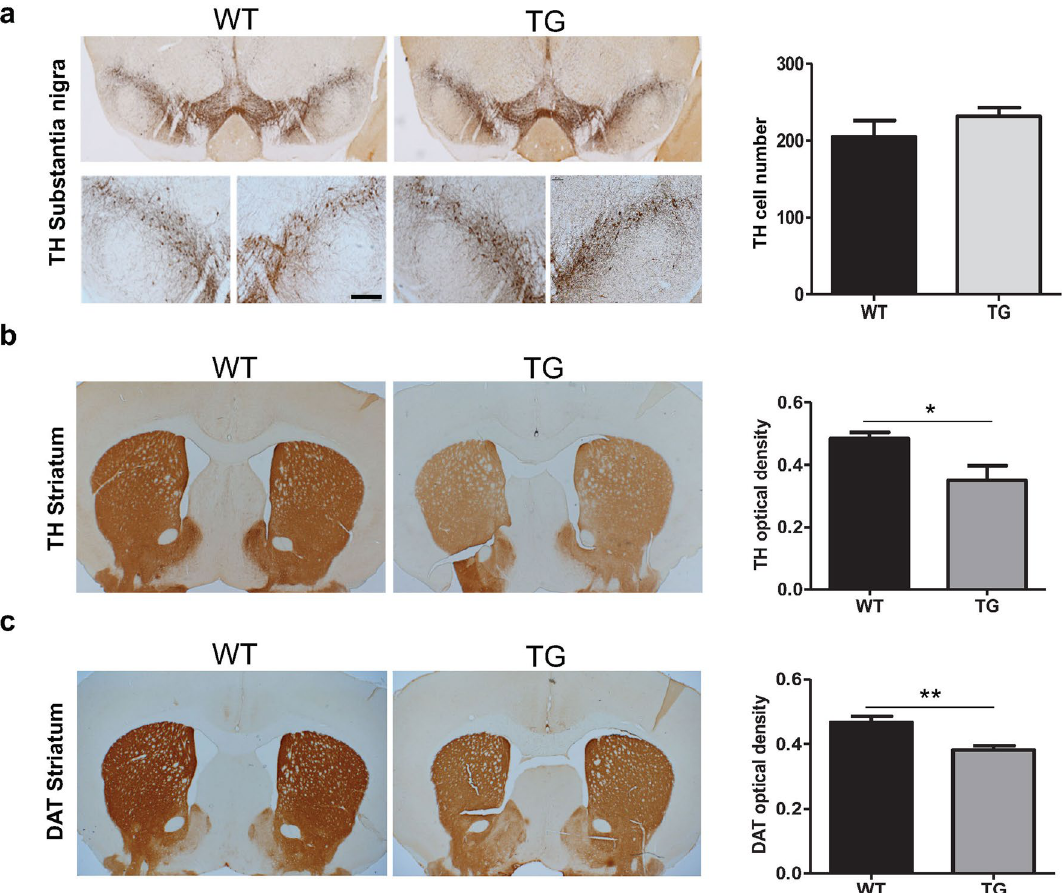
Figure 2. TH cell survival and reduction in TH and DAT density in TG mice. ( a ) TH + staining and TH + cell count in the SNpc of TG and WT mice at age 13 months (n = 4 WT, 5 TG). ( b ) TH + fibre optical density in the striatum of TG and WT mice at age 13 months (n = 5 WT, 5 TG). ( c ) DAT + fibre optical density in the striatum of the TG and WT mice at age 13 months (n = 3 WT, 5 TG). Two-tailed student’s t-test: *p-value < 0.05, **p < 0.01. Scale bar: 50 μm. DAT = Dopamine transporter, TH = Tyrosine